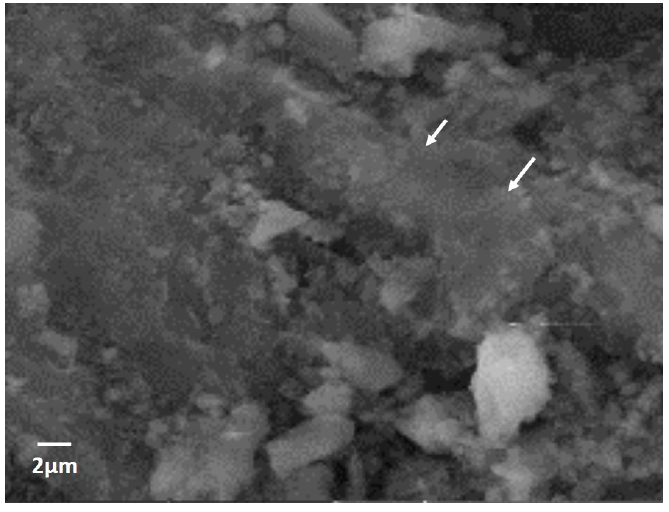
Figure 10. SEM image shows microstructure of a failed specimen (Mix 6); White arrow emphasizes the effective reinforcement of CNTs at the